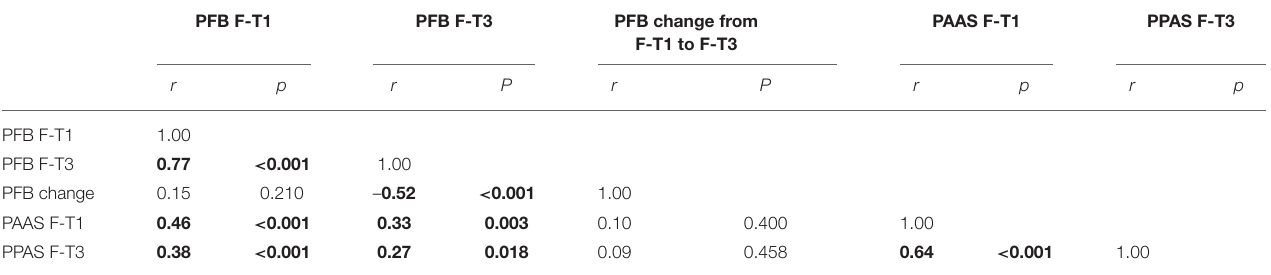
TABLE 4 | Intercorrelations between partnership quality and father-to-child-attachment.